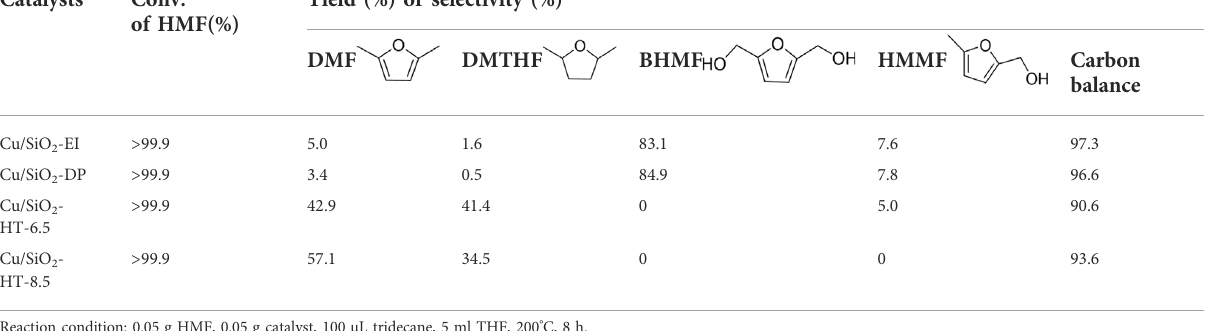
TABLE 3 Catalytic performance of HMF hydrogenolysis over Cu/SiO 2 catalysts prepared by different methods. Catalysts